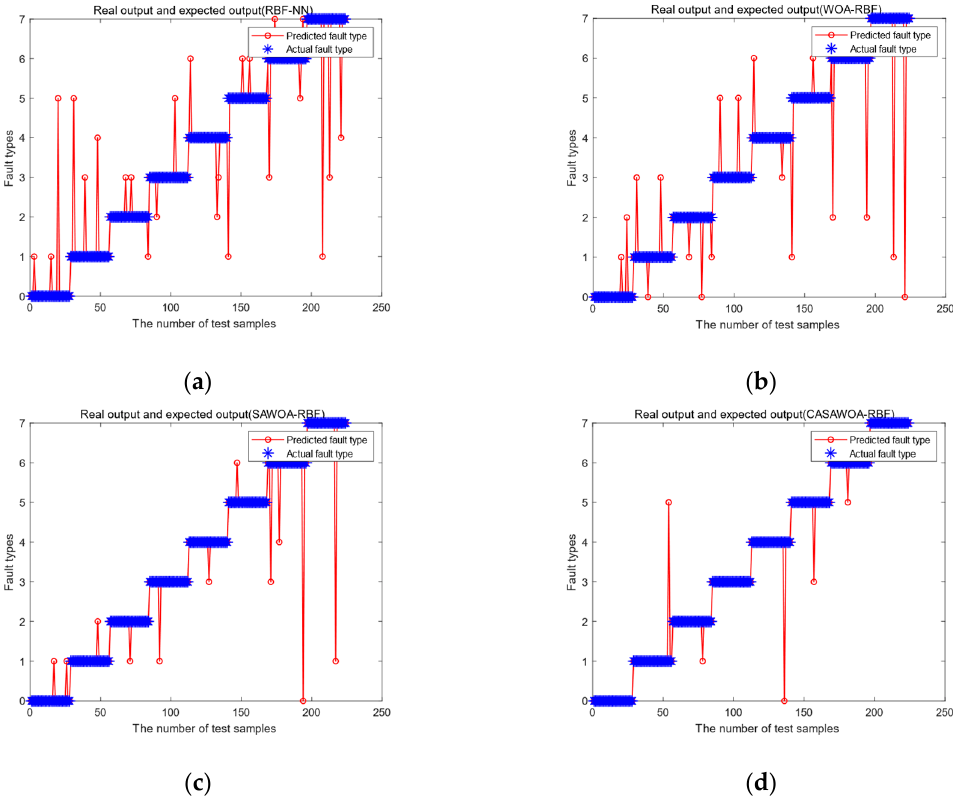
Figure 5. The results of fault diagnosis of the three WOA based RBF network: ( a ) RBF-NN; ( b ) WOA-RBF; ( c ) SAWOA-RBF; ( d ) CASAWOA-RBF. Table 8. The accuracy of WOA-based models and RBF-NN model.